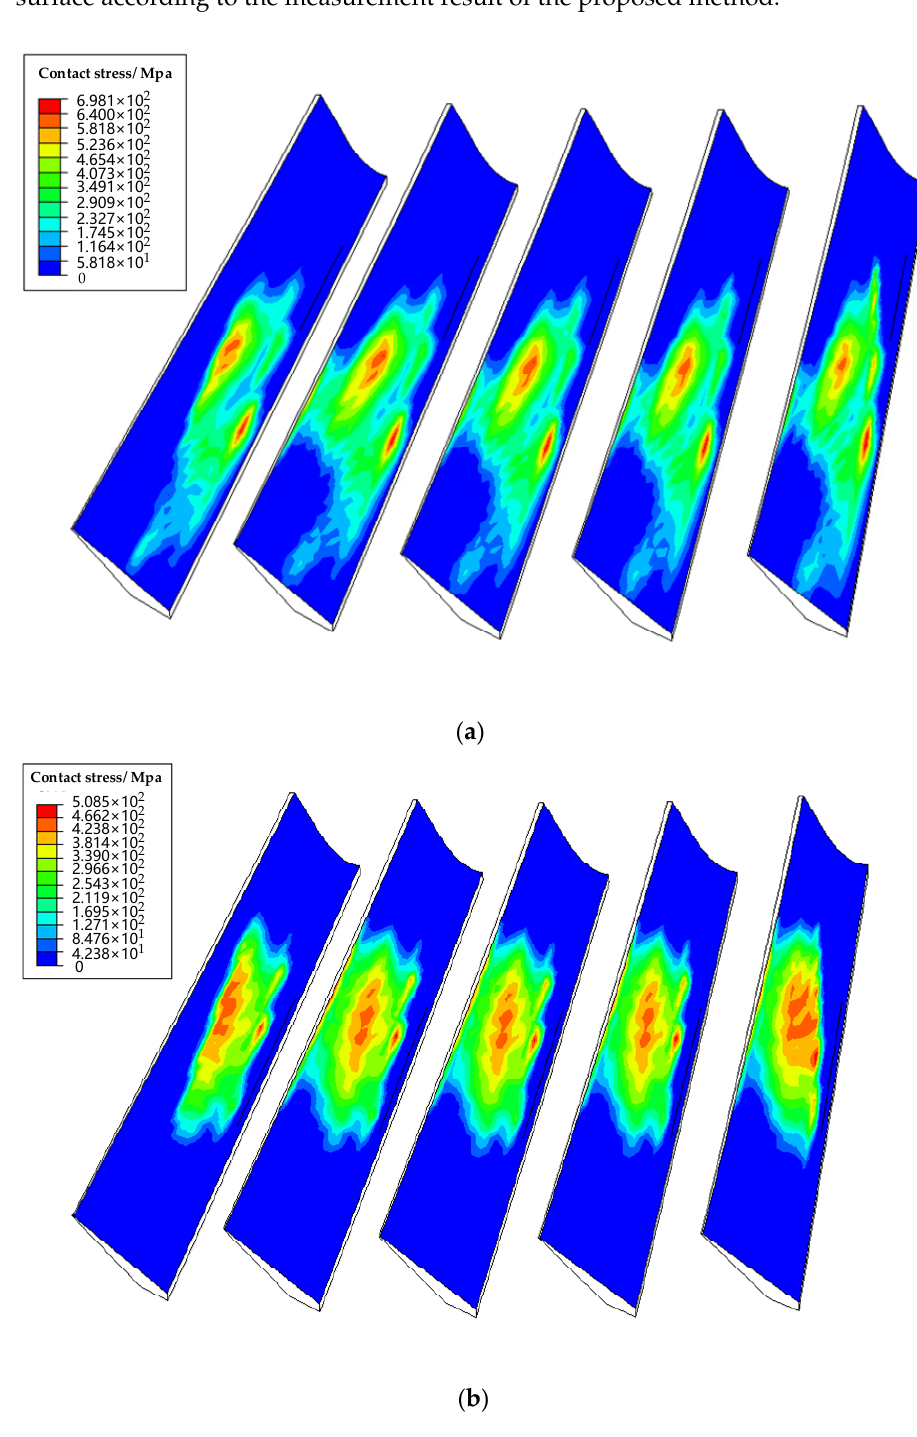
Figure 11. The simulation results for the contact pattern and contact stress of ( a ) the real face gear drive and ( b ) the designed face gear